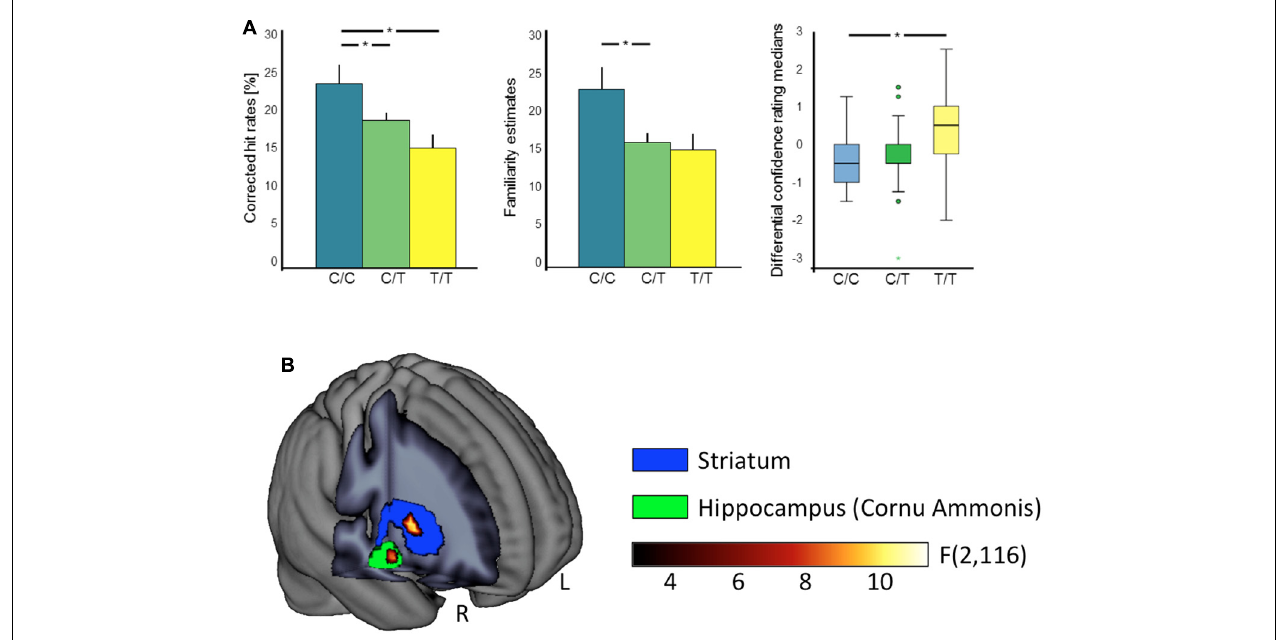
FIGURE 1 | Effects of the C957T polymorphism on behavioral and fMRI correlates of reward memory. (A) Significant behavioral C957T genotype effects on episodic memory performance. Bar plots depict overall corrected hit rates (left) and familiarity estimates (middle) with standard errors. The C957T C allele is associated with an overall higher recognition performance. The box plot (right) depicts differential confidence rating medians (rewarded vs. neutral) in the monetary reward category. Horizontal lines represent the medians, the box represents the 25th and 75th percentiles, the whiskers indicate the 5th and 95th percentiles, dots mark outliers, and the colored asterisks indicate the extremes. Lower values of the C homozygotes indicate a bias to declare rewarded as compared to neutral items as old, independent of their actual item type. ∗ p < 0.05. (B) Neural manifestations of the interaction between C957T genotype and reward category during encoding. Significant interactions of C957T genotype and reward category in right hippocampus (green) and striatum (blue). Statistical F -map and ROIs for small volume alpha error correction overlaid on a mean anatomical image. L, left; R,